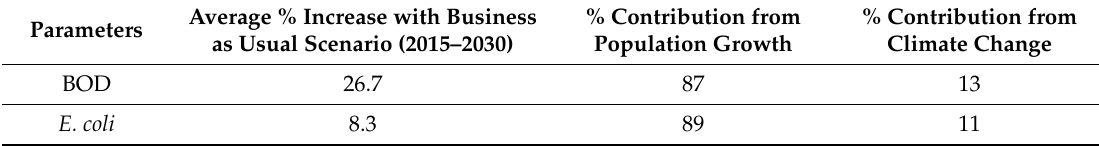
Table 3. Summary of e ff ect of individual parameters on simulated water